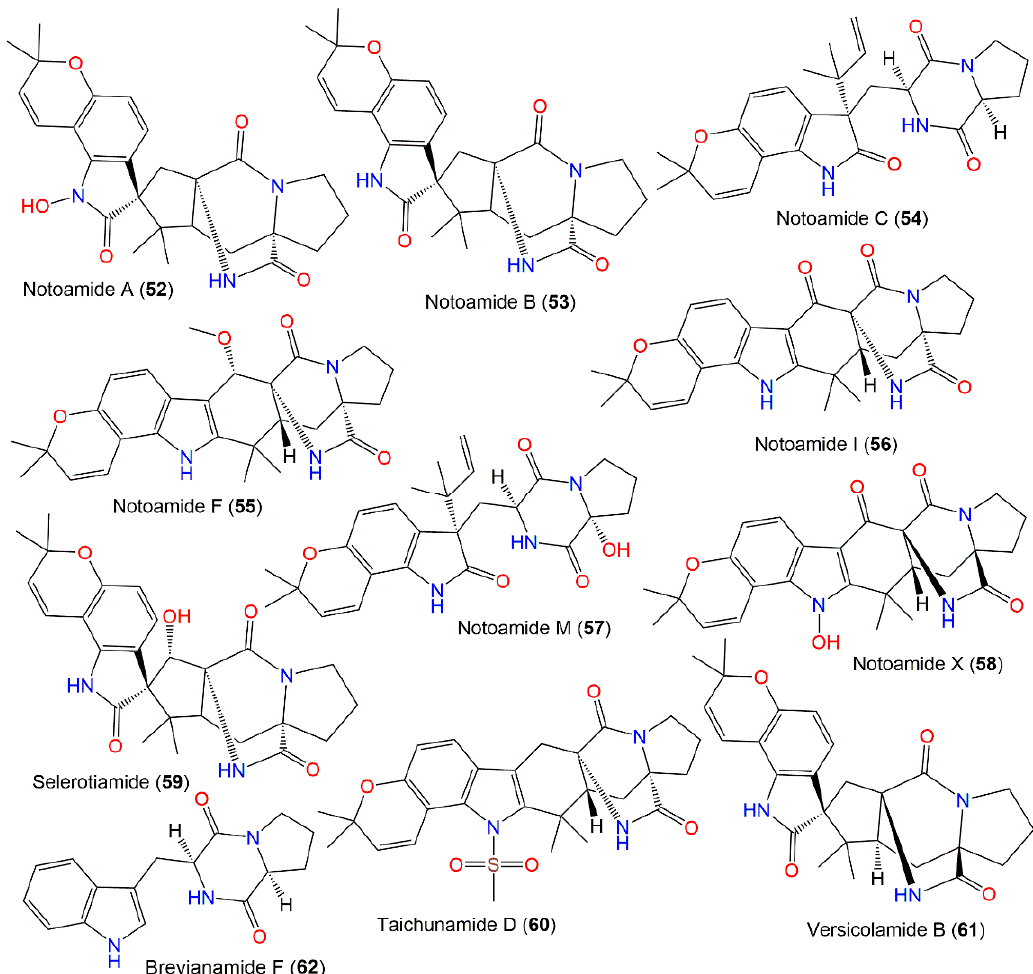
Figure 5. Diketopiperazines derivatives ( 52 – 62 ) reported from A. ochraceus.